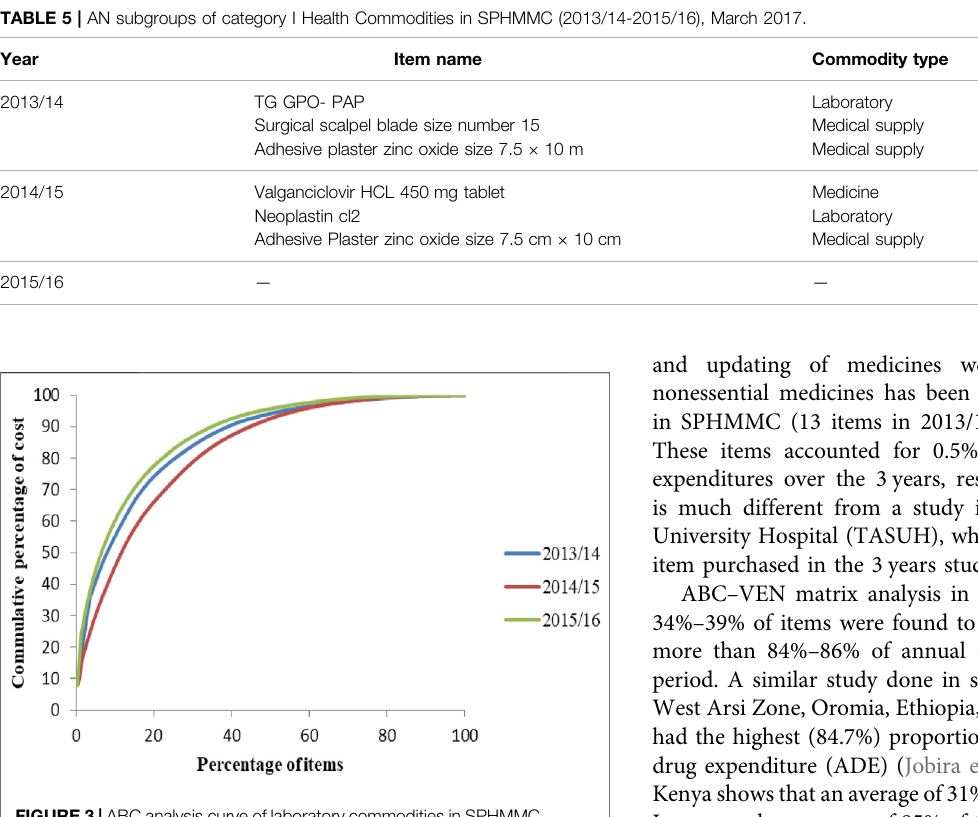
FIGURE 3 | ABC analysis curve of laboratory commodities in SPHMMC (2013/14 – 2015/16), March 2017.